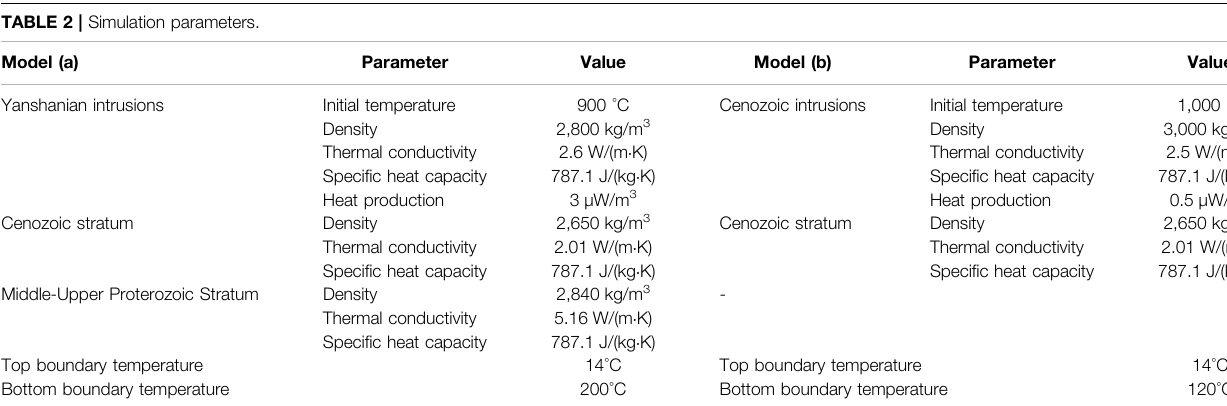
TABLE 2 | Simulation